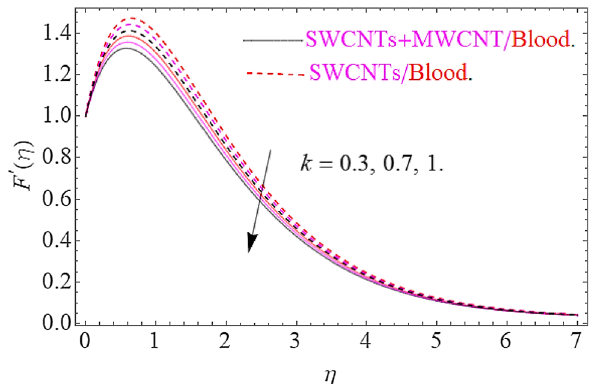
Figure 6. Effects of k on F ′ (η) .